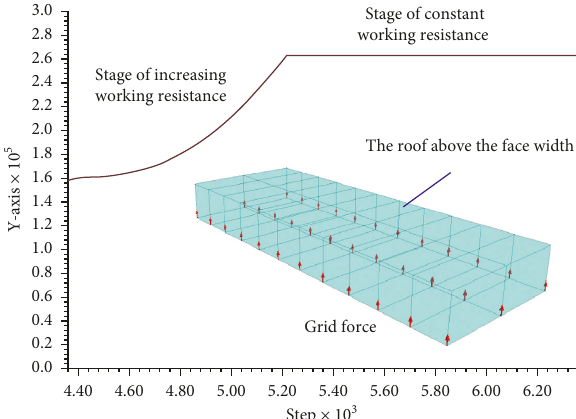
Figure 12: Numerical model of the grid force.